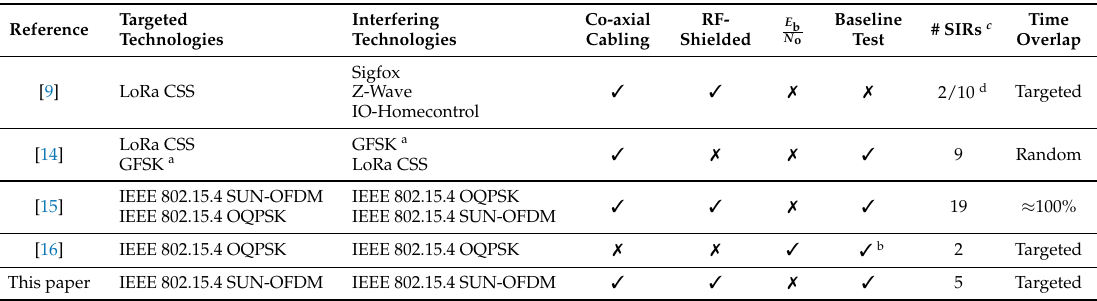
Table 1. Summarized comparison of empirical interference robustness evaluation techniques for Wireless Sensor Networks